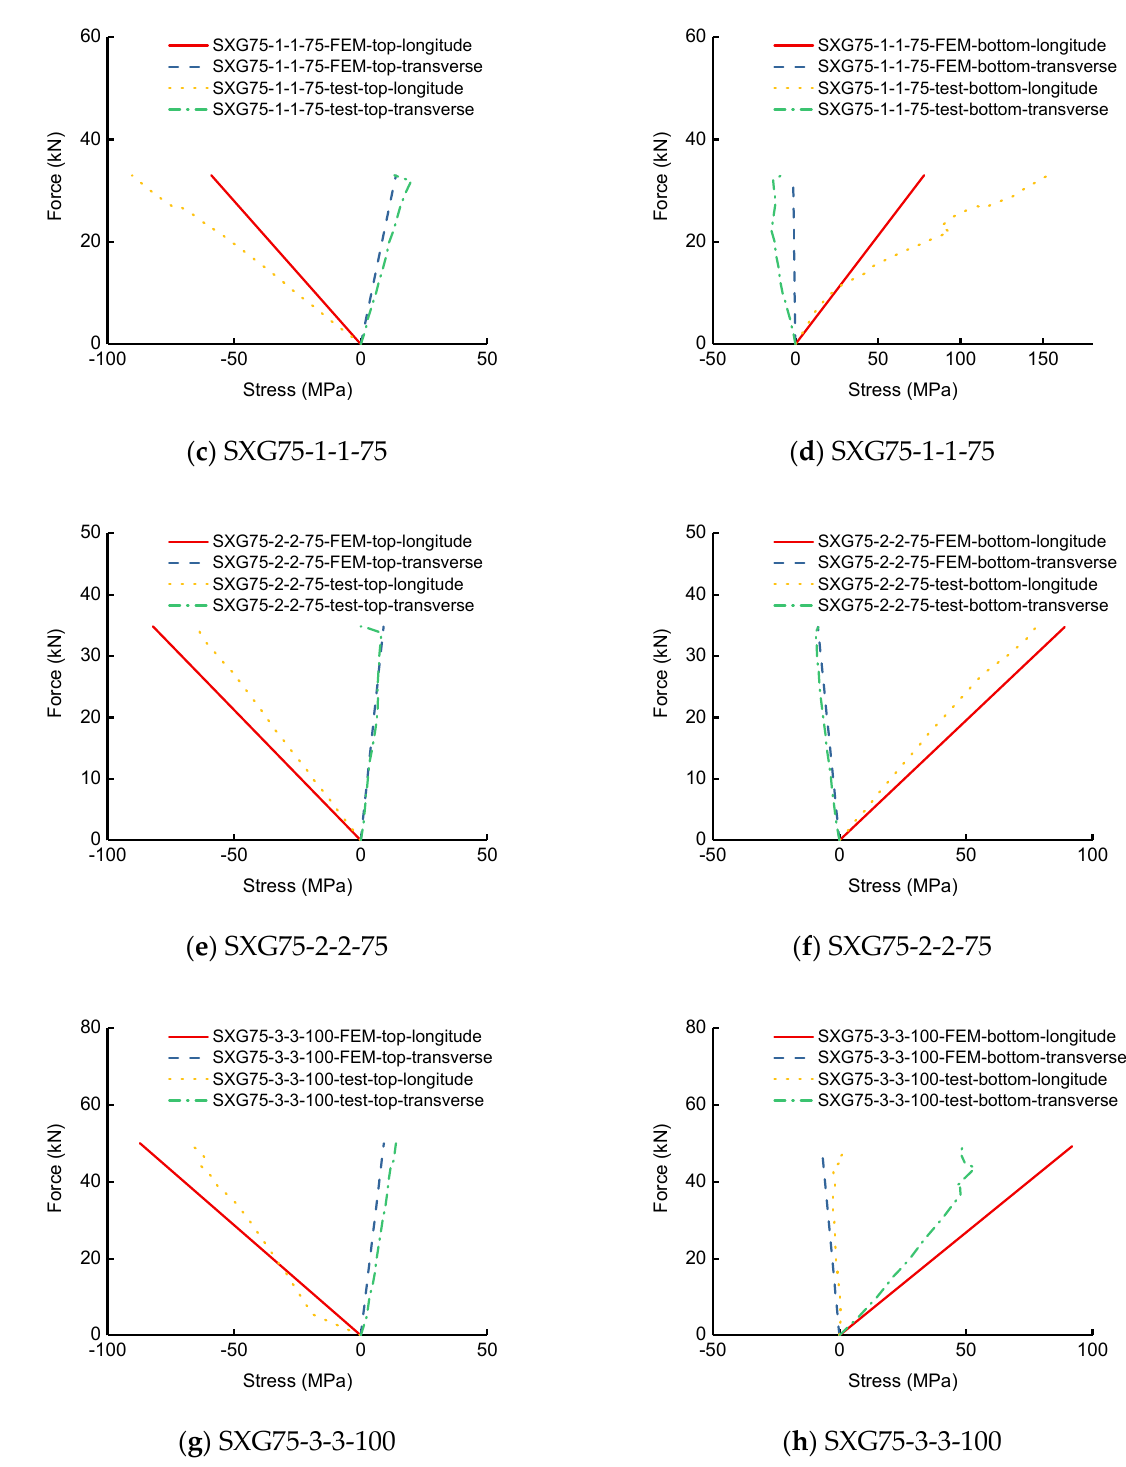
Figure 10. Load-normal stress curves on the mid, top, and bottom surfaces of single-way simply supported SLCPs. In accordance with Table 6, the bottom deflection errors between the test and FEM for single-way simply supported SLCPs were within 1–31%. Based on Table 7, the longitudinal normal stress errors on the top surface were within 11–35%; the transverse errors were within 2–35% except for SXG-2-2-75, which cannot be estimated by the current error method; the longitudinal normal stress errors at the bottom surface were within 14–50%; the transverse errors were within 3–140%. Both the test load-midspan deflection